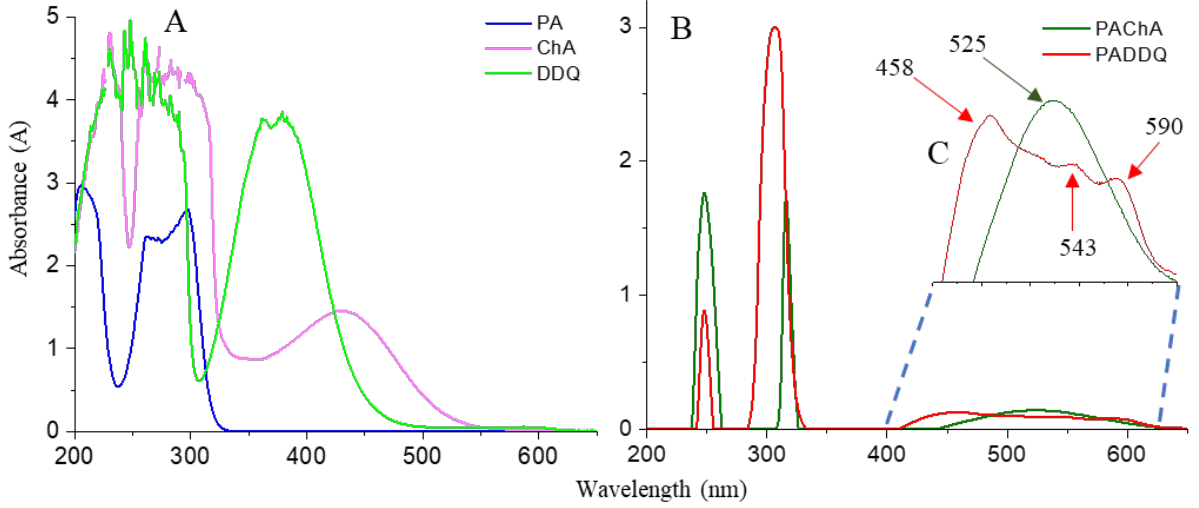
Figure 3. Spectrophotometric titration curves of A PA-ChA and B PA-DDQ CT complexes in acetonitrile at the detectable peaks (donor and acceptor, 1 × 10 −3 M).